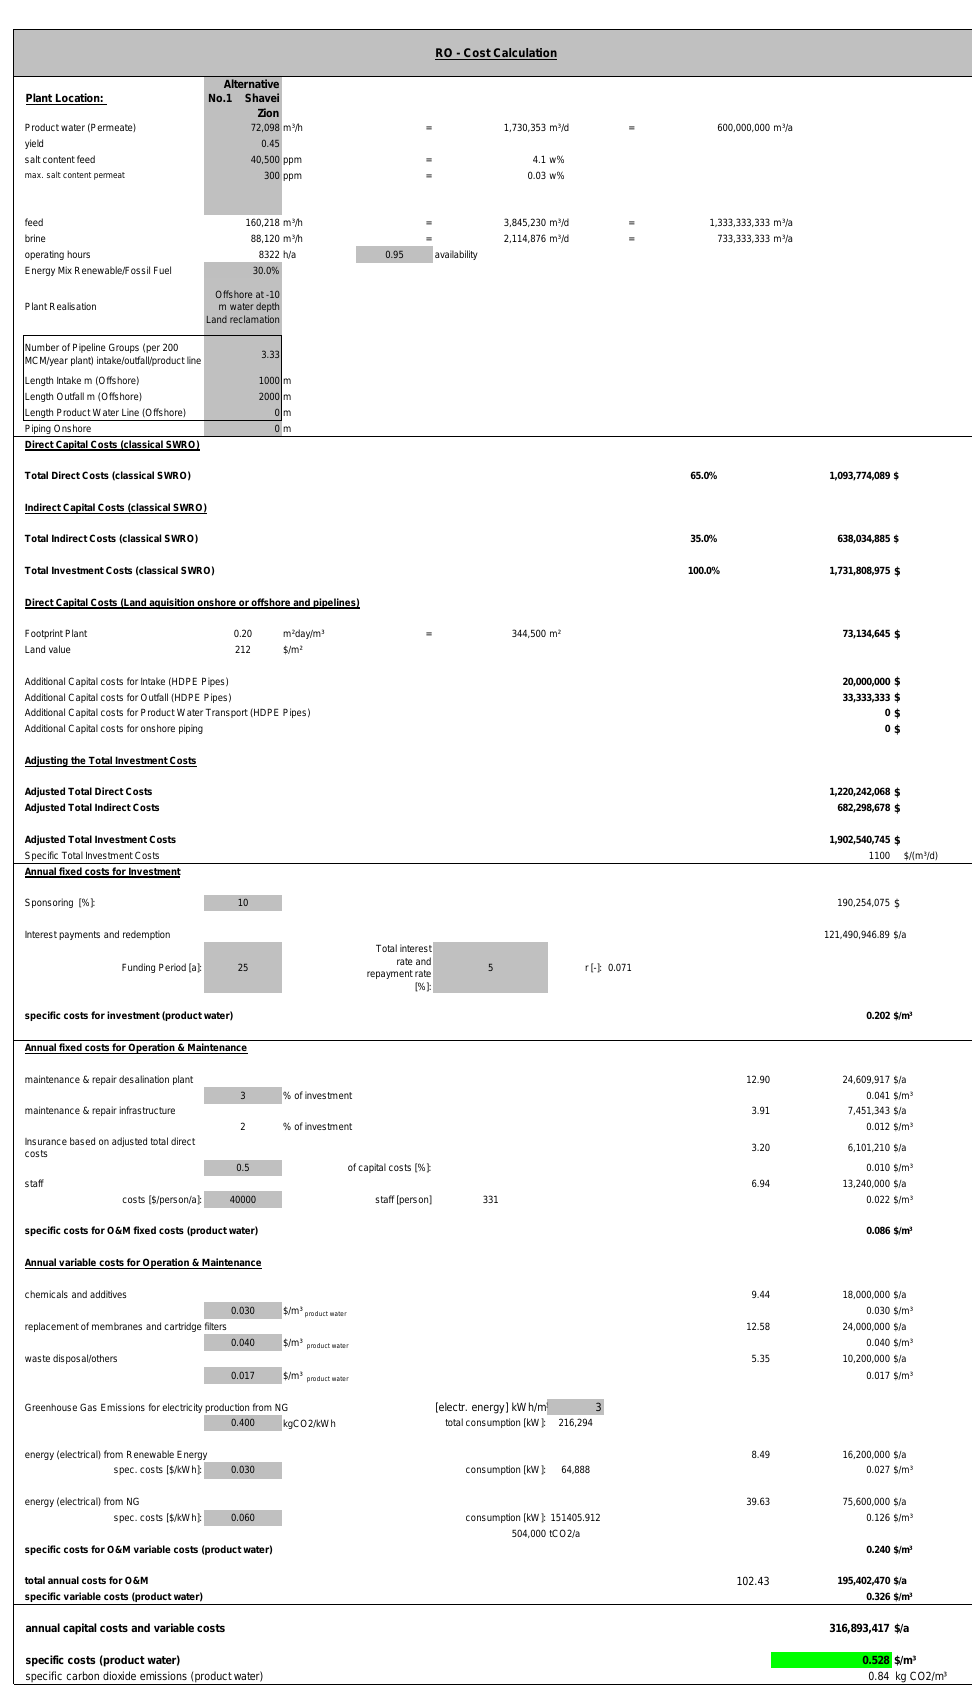
Figure A2 Detailed cost table for the economic analysis — Alternative No. 1. Figure A2. Detailed cost table for the economic analysis—Alternative No.